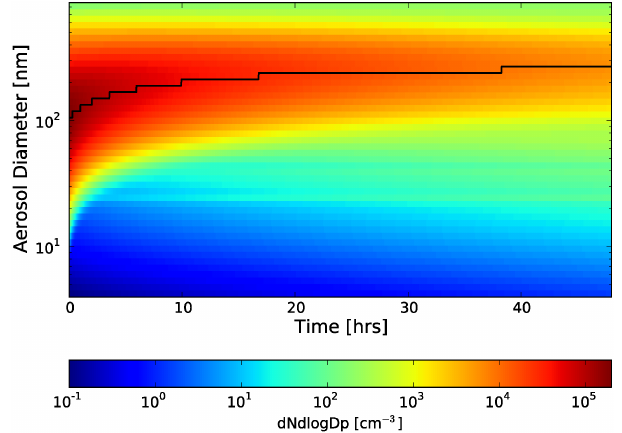
Figure 10. Plot of modelled size-distribution evolution for τ dil = 36h. The black line shows the peak diameter at each time step ( (cid:49) t = 10s). The young-plume size distribution has optimal